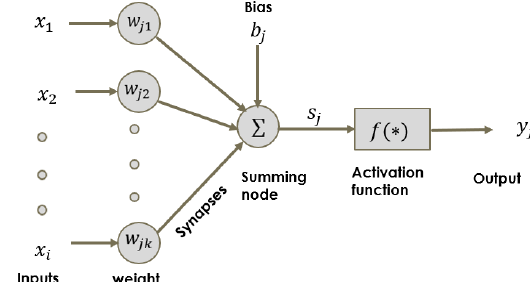
Figure 4. The model of a non-linear